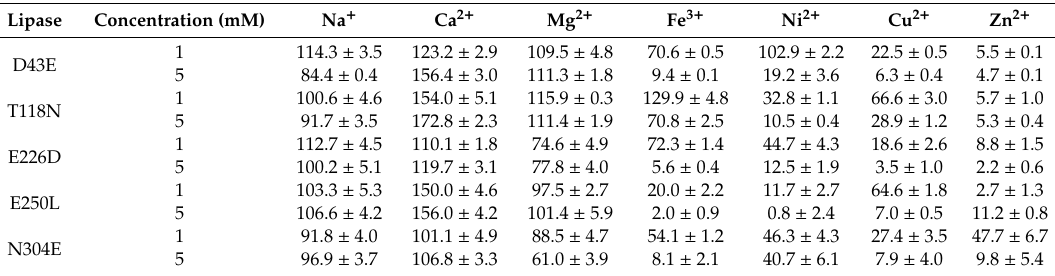
Table 2. E ff ect of metal ions on the lipase activity of mutated HT1 lipases. The relative activity of each lipase was compared to the untreated lipase without metal ions. The value of untreated enzyme for each mutant HT1 lipase was taken as 100% and not presented in the table.